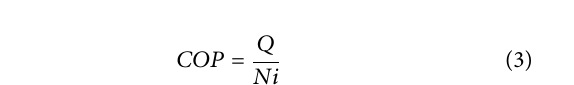
Frontiers in Earth Science |